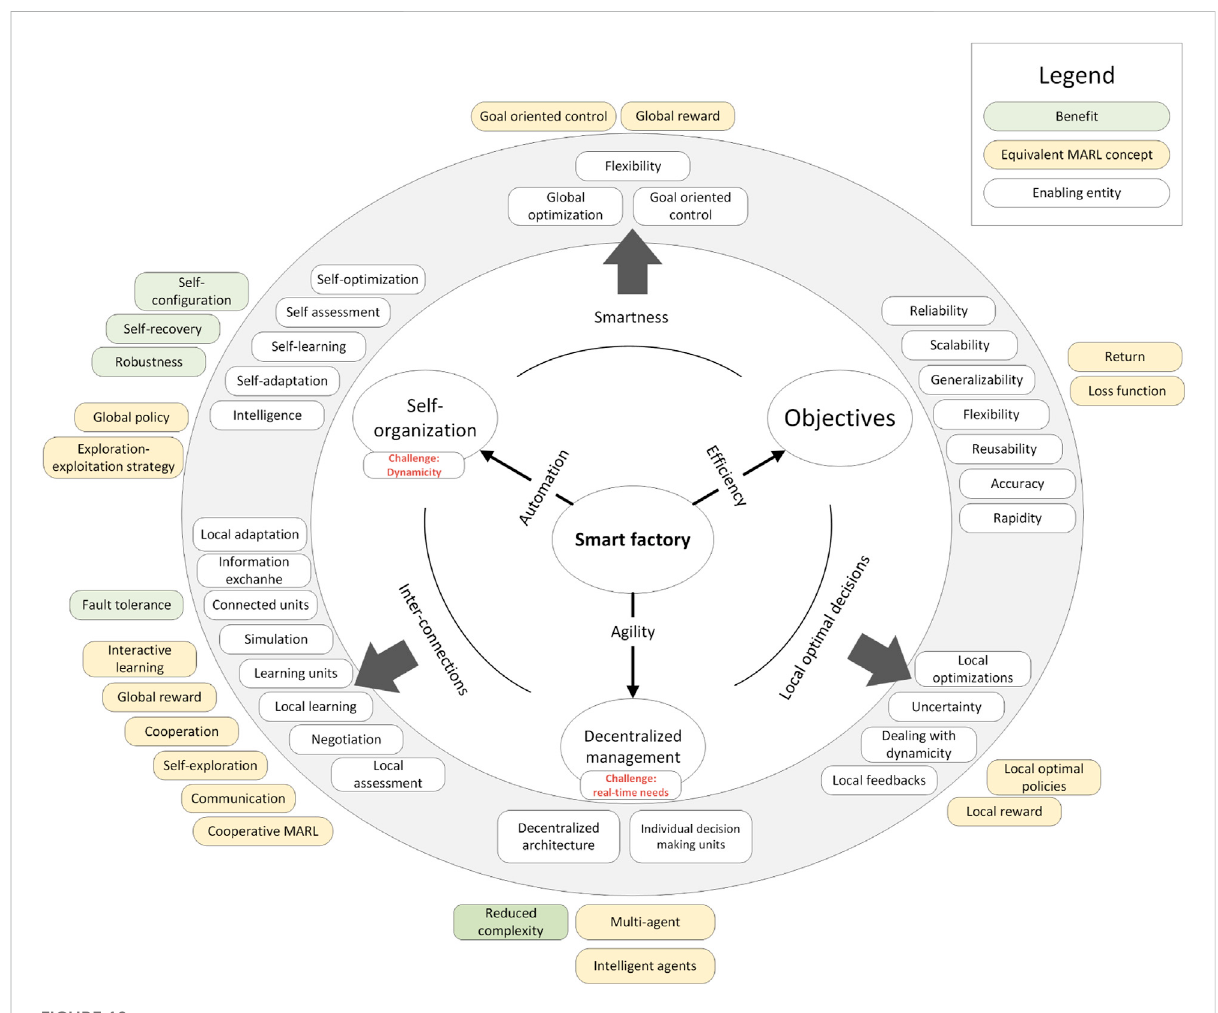
FIGURE 10 Mapping from smart factory features and MARL